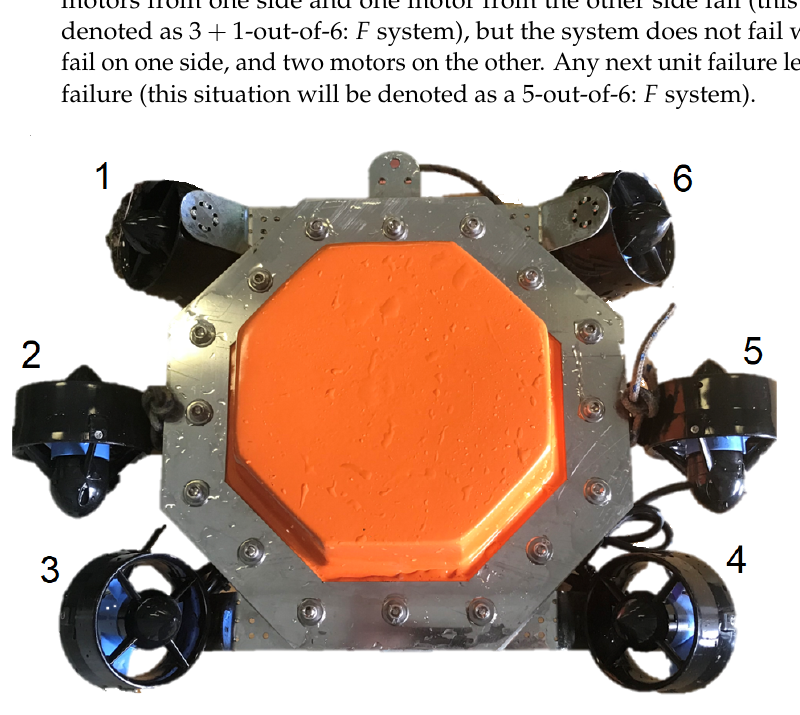
Figure 1. The unmanned underwater